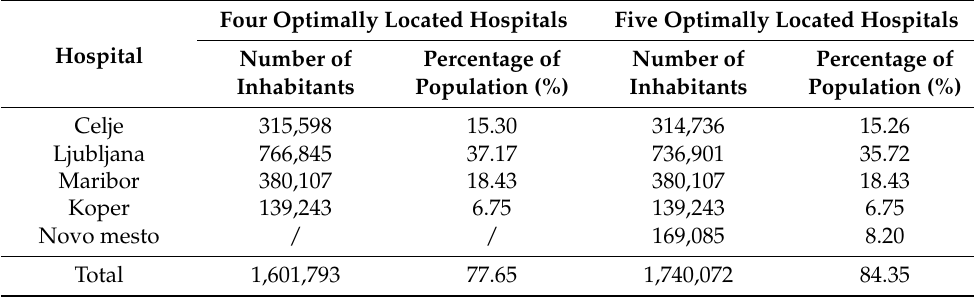
Table 2. Number of general hospitals and a coverage rate of the population within the 45-min time interval. Four Optimally Located Hospitals Five Optimally Located Hospital